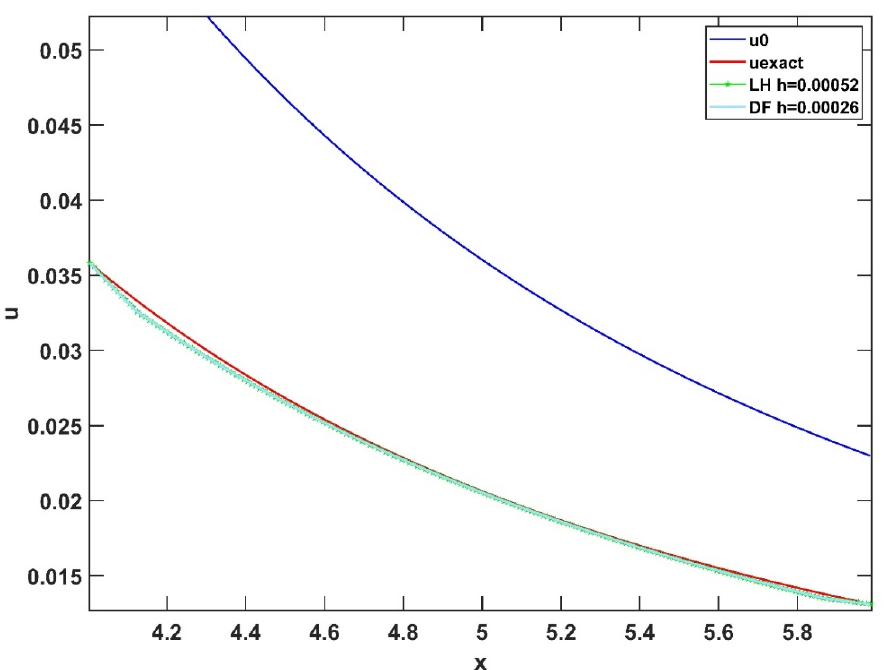
Figure 9. The concentration u as a function of the x variable in the case of the initial function u 0 , the analytical solution at t fin , the LH method for h = 5.2 · 10 − 4 , and the DF method for h = 2.6 · 10 − 4 in the case of Experiment 2. The LH and the DF curves almost coincide.